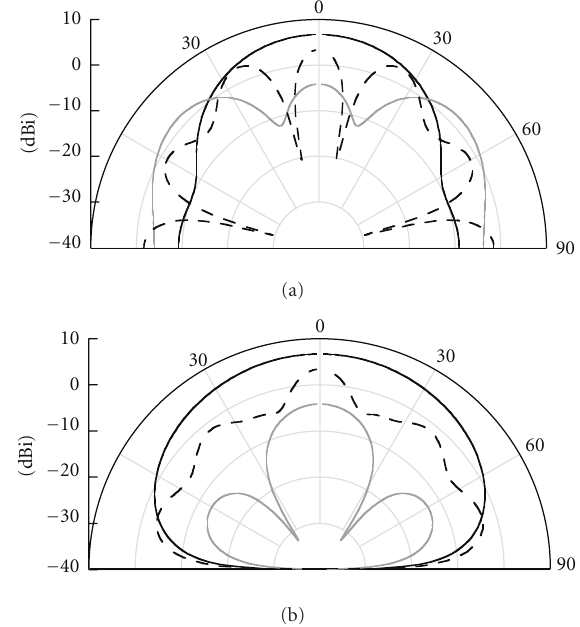
Figure 4: Antenna in Figure 1. Gain in polar form on the principal elevation plane φ = 0 ◦ of the single element at di ff erent frequencies in the operational bandwidth 5–25 GHz: 5GHz ( solid black line ), 10GHz ( solid gray line ), 20GHz ( dashed black line ). (a) Ports 1 and 2 are fed, exciting a field along the θ direction. (b) Ports 3 and 4 are fed, exciting a field along the ϕ